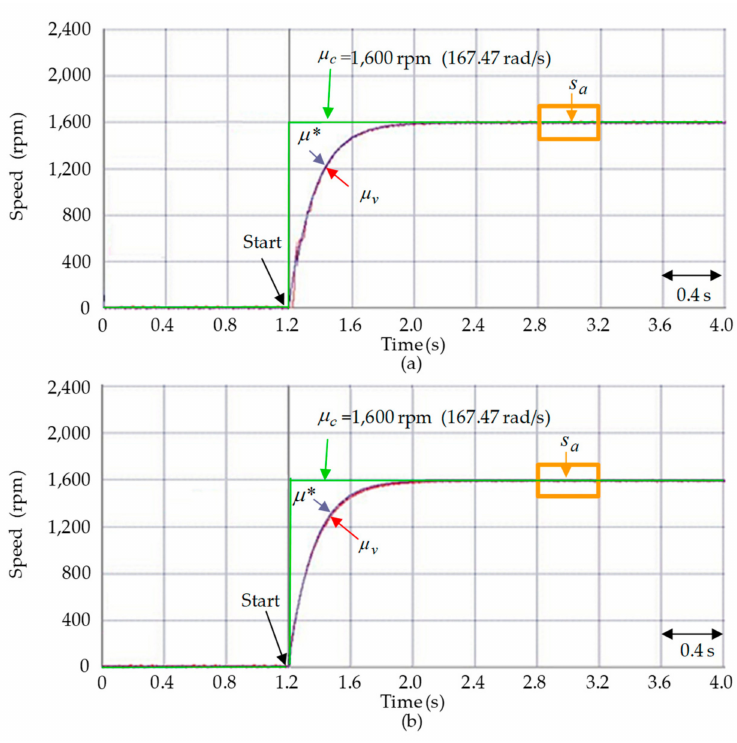
Figure 7. Speed responses via experimental results for the ISM driving the rice milling machine system at test JA by adopting the controllers: ( a ) TA; ( b )